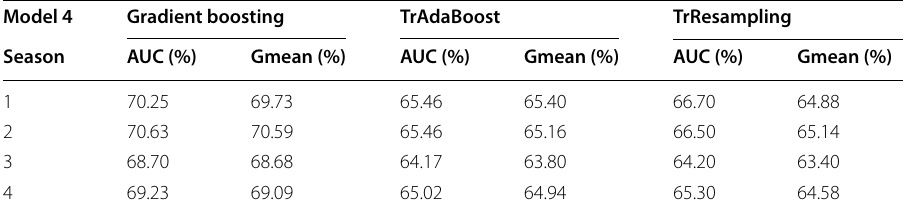
Table 7 AUC and Gmean scores based on Toronto and Halifax data (model 4) Model